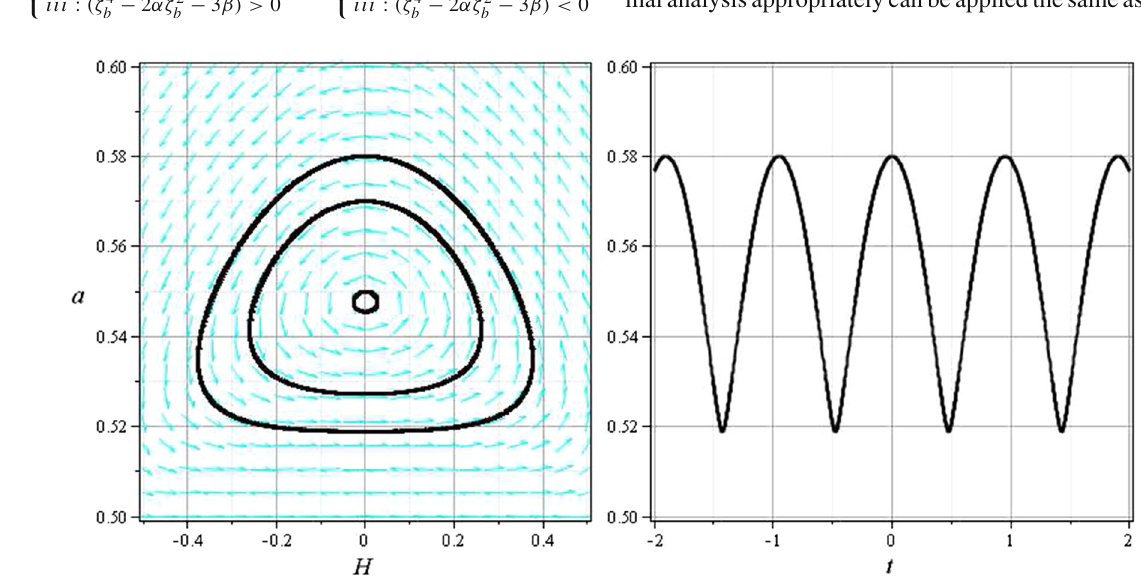
Fig. 12 The two dimensional phase plane for parameters ( a , H ) . We have set k = − 1 ,α = 0 . 7, β = − 0 .